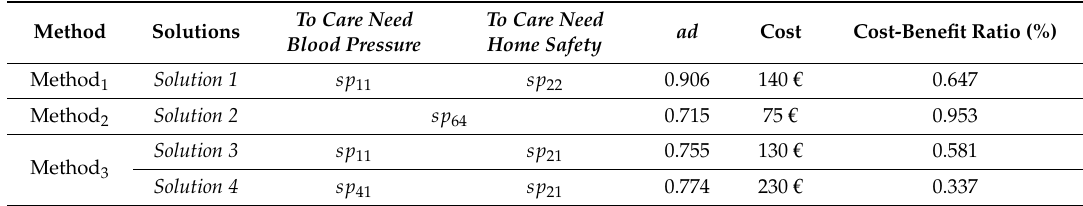
Table 13. Solution’s matrix for Mr. Silva’